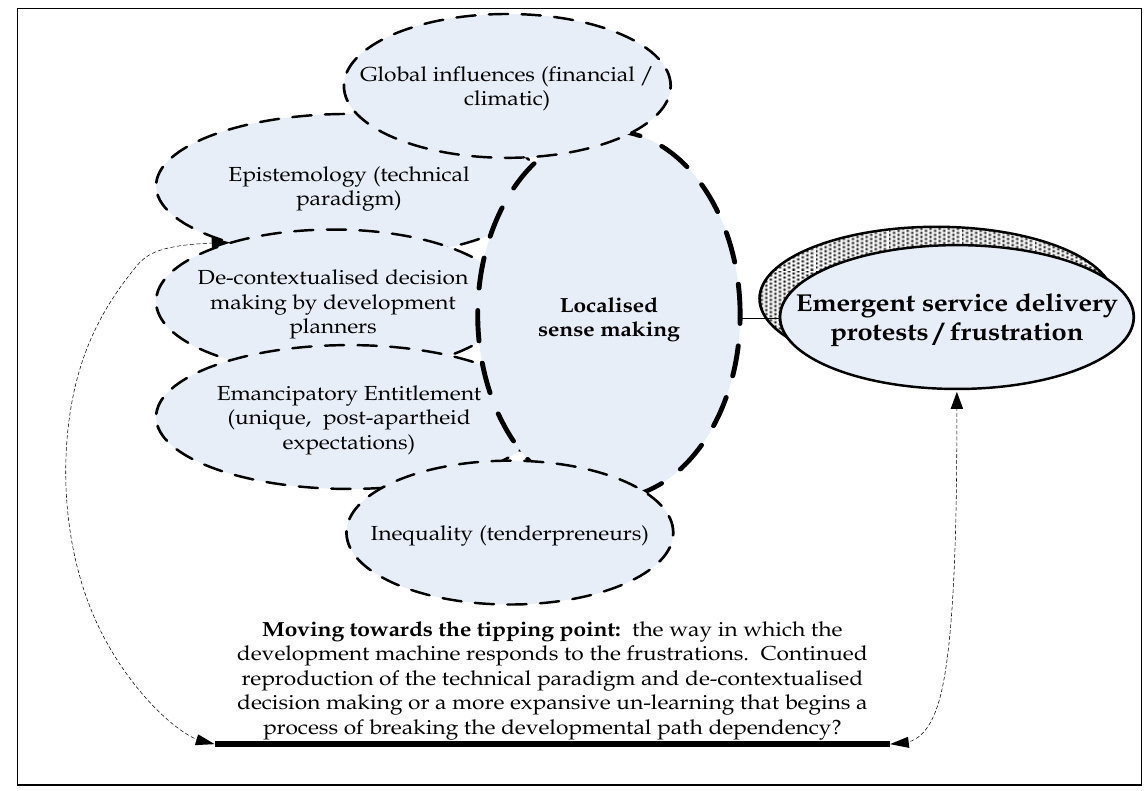
Figure iii: Localised sense making to contradictory systemic changes. Source: Authors’